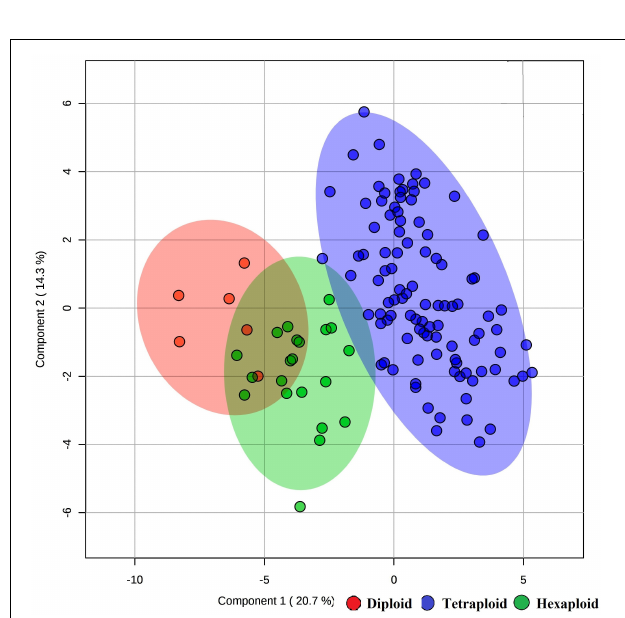
FIGURE 6 | PLS-DA model of metabolite and fruit quality data from 128 blueberry accessions in three ploidy levels (diploid, tetraploid, and hexaploid). The figure representing the first two components of the PLS-DA